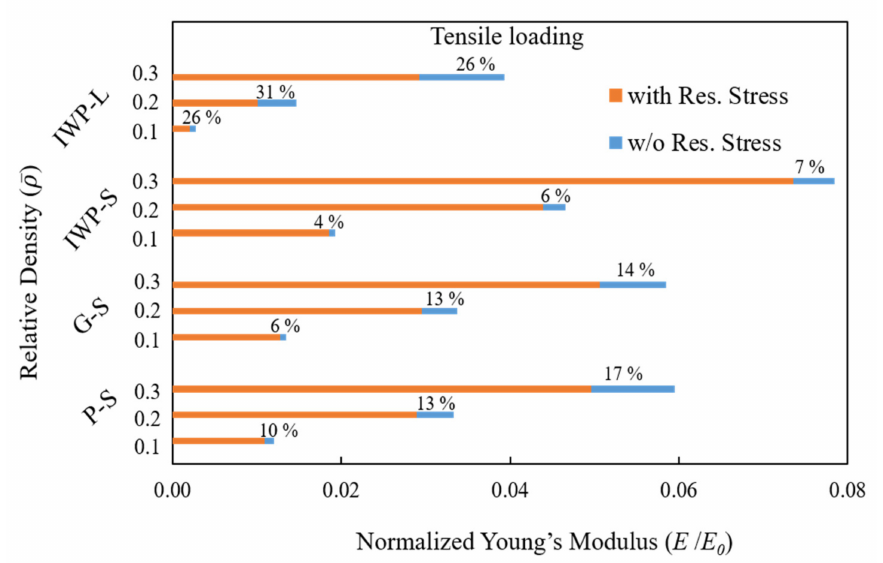
Figure 16. The reduction in Young’s modulus in percentages for tensile loading for all TPMSs and their relative densities.